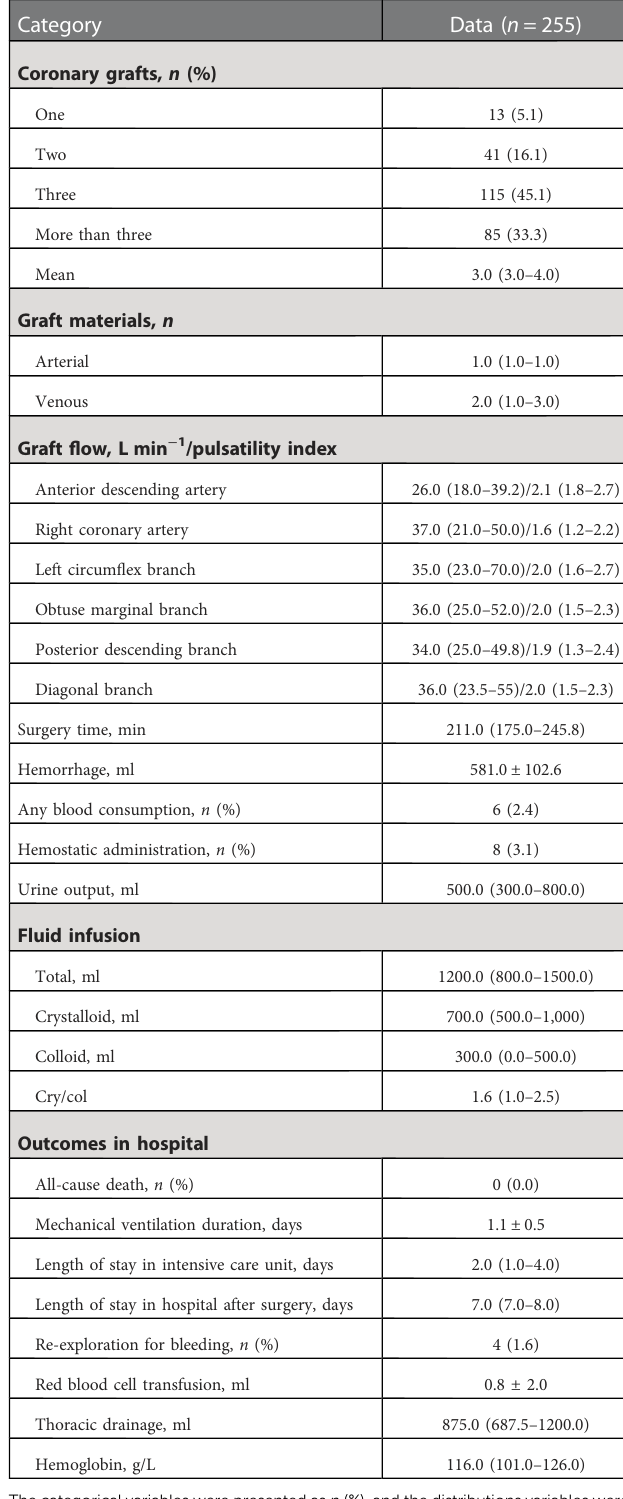
TABLE 2 Surgical characteristics and short-term